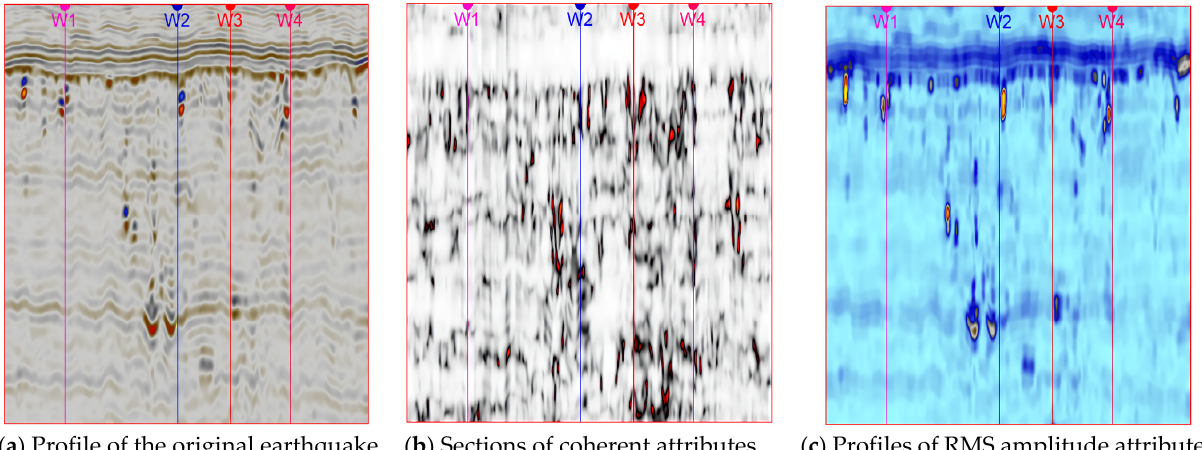
Figure 4. The seismic cross section of A well group.